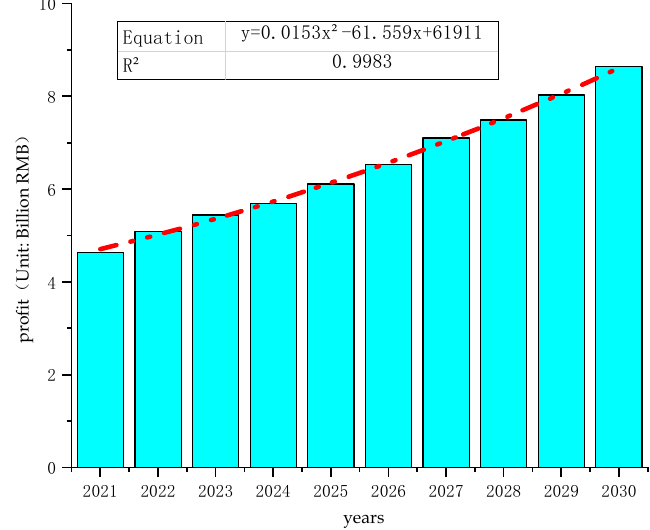
Figure 15. The future profits and the number of Guixin Expressway. As shown in Figure 15, the blue bars represent annual profits, and the red dotted lines represent profit growth trends. The profit of the Guixin expressway dynamic wireless charging project increases year by year. The relationship between the profit and the number of years of operation is: y = 0.0153 x 2 − 61.599 +